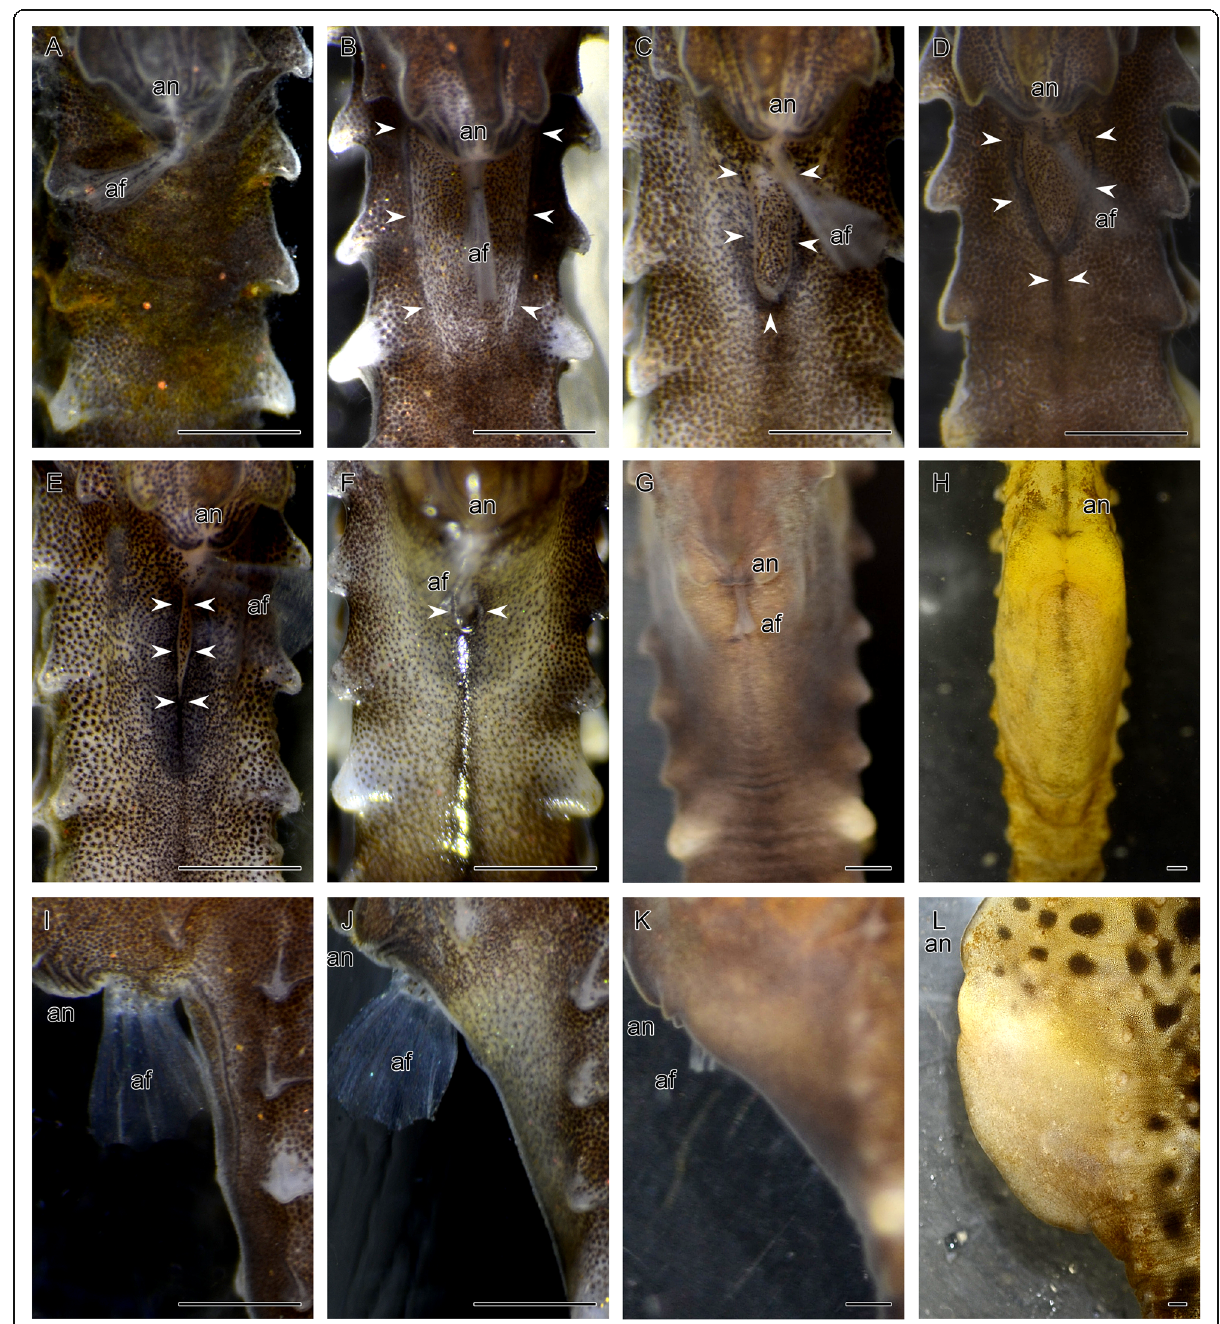
Fig. 3 External observations during seahorse brood pouch formation. Ventral views ( a – h ) and lateral views ( i – l ) of the tail of a male seahorse, observed 20 – 30 days ( a – f , i , j ), five months ( g , k ), and eight months ( h , l ) after birth. ( a ) Before formation of the brood pouch primordia. The order of brood pouch development is depicted in b – f : ( b , i ) primordium of the brood pouch as parallel linear projections; ( c ) elongation of the projections; ( d ) a seam line forming a Y-shape; ( e ) a seam line forming an I-shape; ( f , j ) formation of the pore-like pouch entrance; the expanding pouch as development proceeded to five months ( g , k ) and eight months ( h , l ) after birth. Arrowheads point to edges of the brood pouch. af, anal fin; an, anus. Scale bars: 1